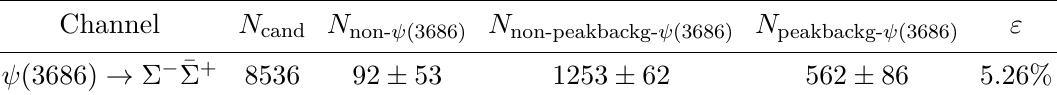
Table 1 . The number of total events selected by the kinematic fit, the number of non- ψ (3686) background events, the number of non-peaking background events from ψ (3686) decay, the number of peaking background events from ψ (3686) decay, and the detection